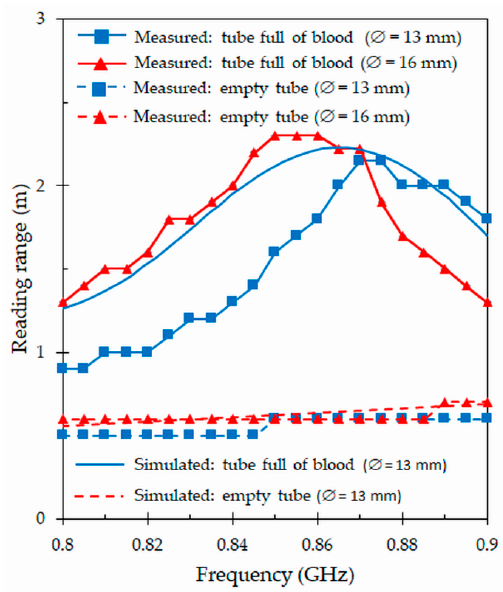
Figure 10. Simulated and measured reading ranges obtained for the proposed tag attached to two standards ( ∅ = 13 mm and ∅ = 16 mm) of full and empty blood tubes.